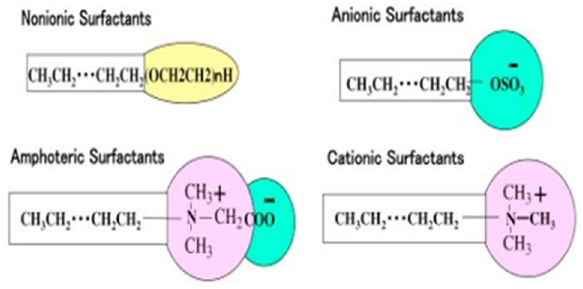
Fig. 8 Examples and structure of surfactant molecule (Nakama 2017)